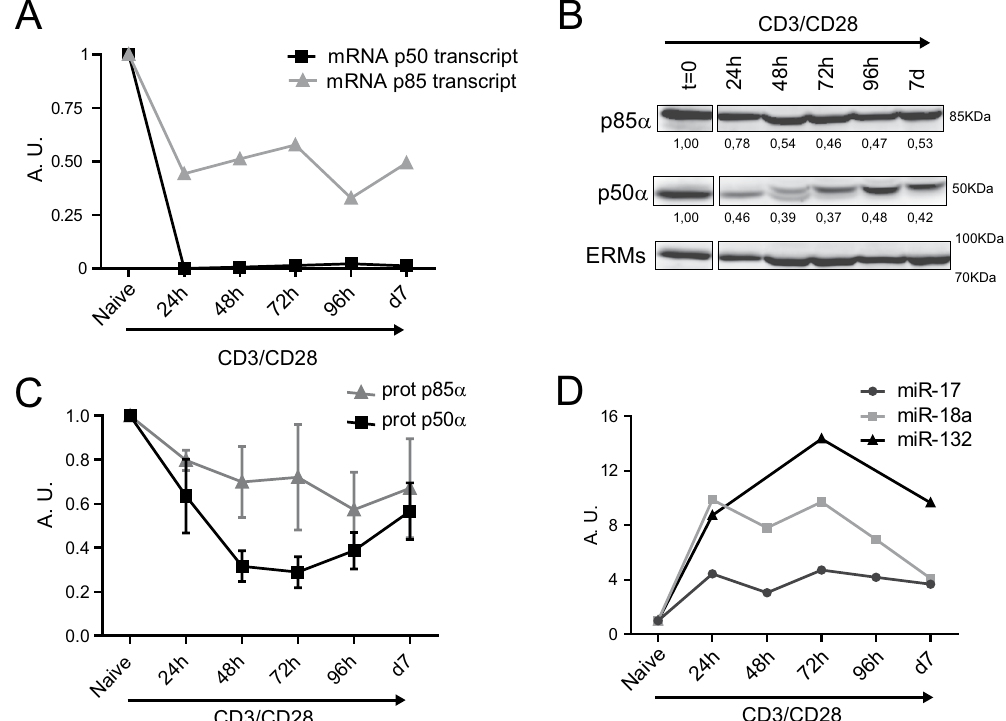
Figure 2. pik3r1 is downregulated during T cell activation. (A) mRNA relative levels of the two main transcripts of pik3r1 were measured by qPCR. Levels were normalized to Yhwaz and β -actin housekeeping genes (n = 2). (B) Western blot analysis of p85 α and p50 α protein content in CD4 T cells after activation with anti-CD3 plus anti-CD28. Representative Immunoblots (n = 3); protein bands were cropped from the same gel. ERMs were included as a loading control. (C) Protein levels of p85 α and p50 α in (B) normalized to ERMs. (D) miRNA levels in CD4 T cells after activation with anti-CD3 plus anti-CD28. Levels are normalized to RNU1A1 and RNU5G and presented in arbitrary units (n =